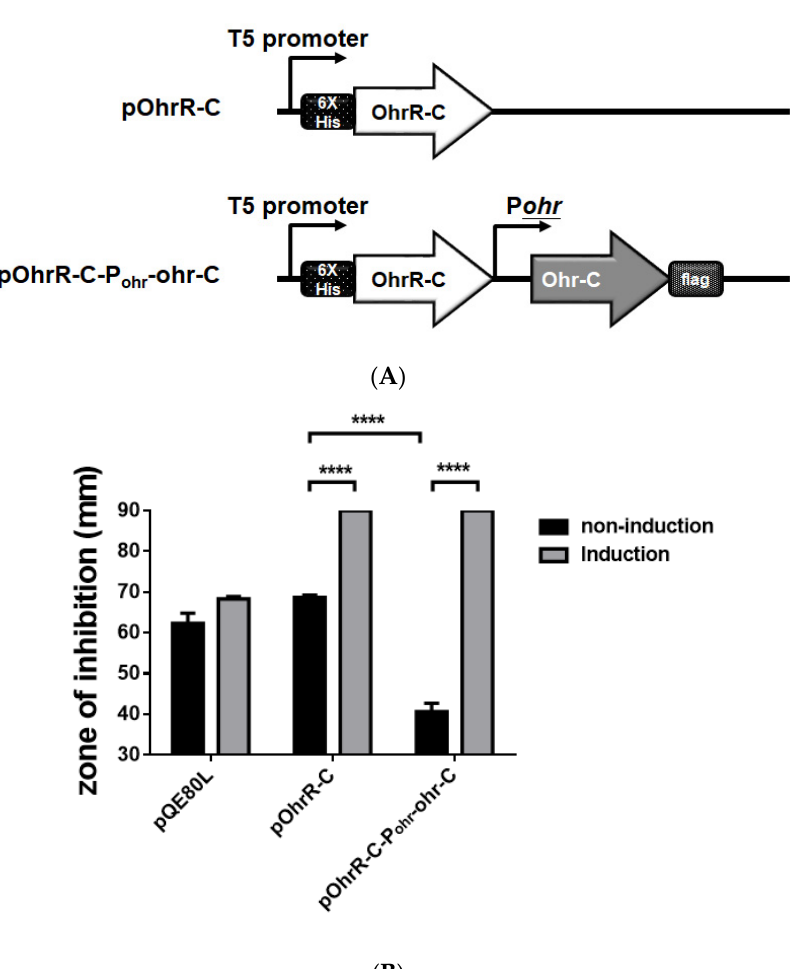
Figure 9. Genetic organization and disk diffusion assay for the gain of function assay in E. coli. ( A ) Genetic organization of OhrR-C expressing strains and OhrR-C-Ohr-C expressing strains. ( B ) Disk diffusion assay. Different E. coli strains without (black bar) or with (gray bar) 1 mM IPTG induction. Cultures were treated with 135 μ g t BHP for 12 h. Multiple-way ANOVA was used to determine the significance of each phase. **** indicates p < 0.0001.